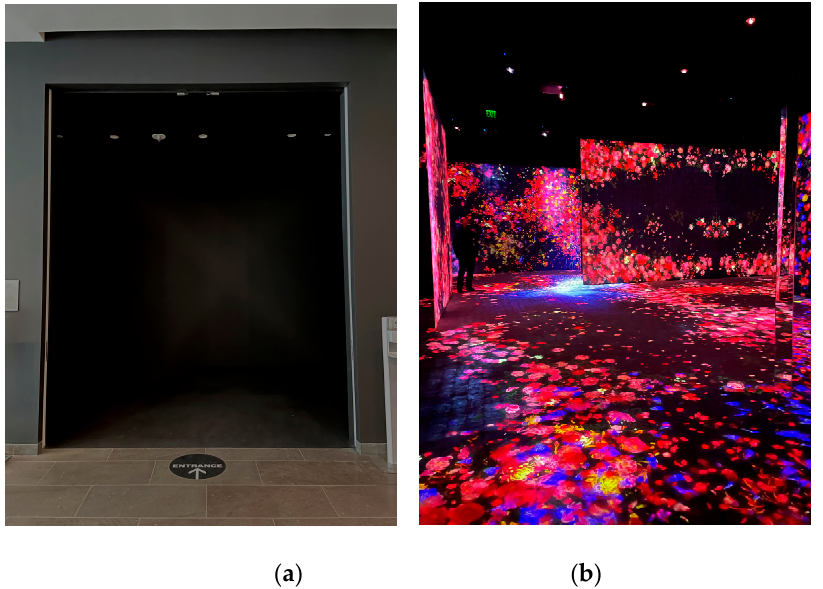
Figure 1. ( a ) teamLab: Continuity entrance, 2021–2022, Asian Art Museum of San Francisco; pho‑ tograph by the author, 2022. ( b ). teamLab, Forest of Flowers and People: Lost, Immersed and Reborn ,